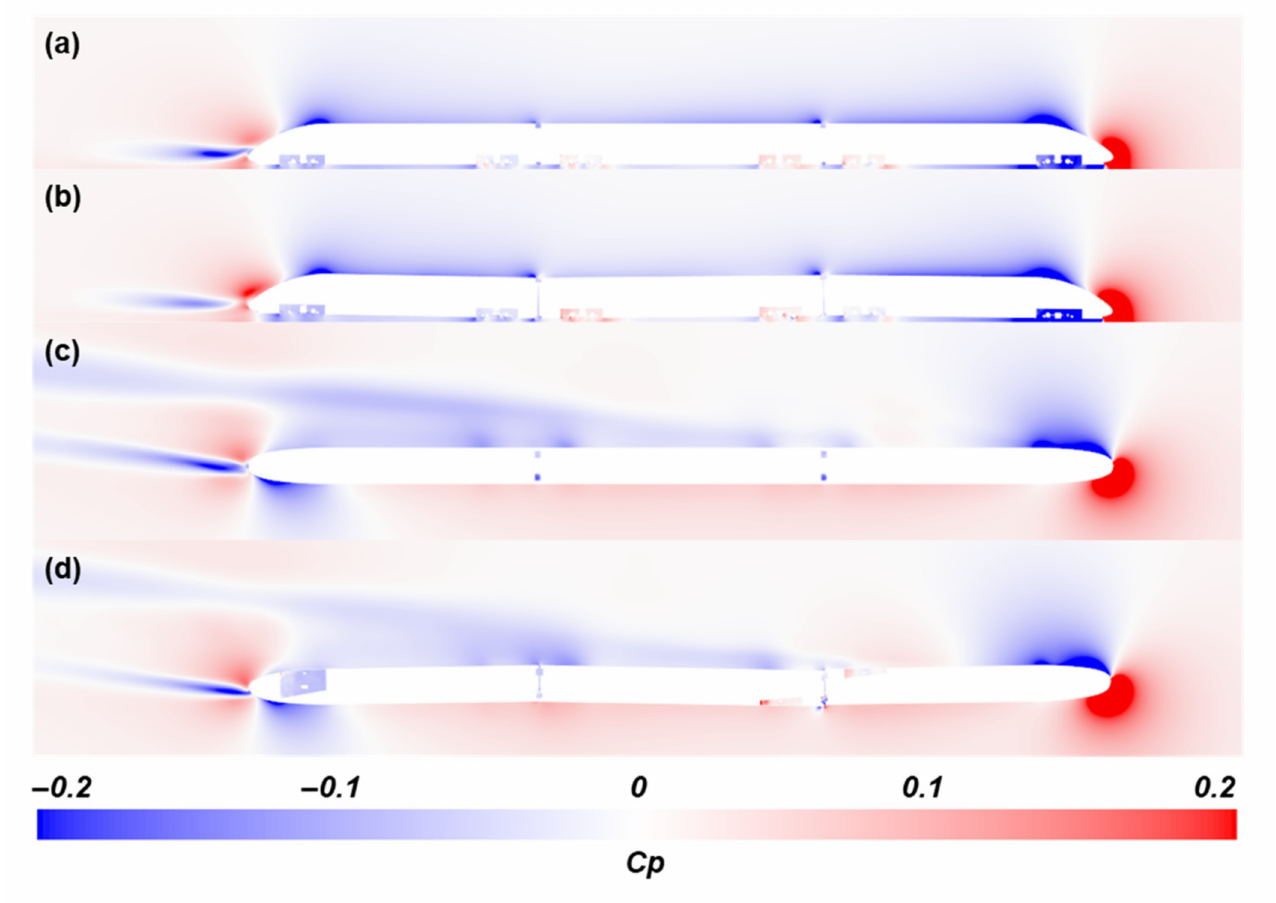
Figure 11. Distribution of c p on: ( a ) the longitudinal plane of the train without posture; ( b ) the horizontal plane of the train without posture; ( c ) the longitudinal plane of the train with posture; ( d ) the horizontal plane of the train with